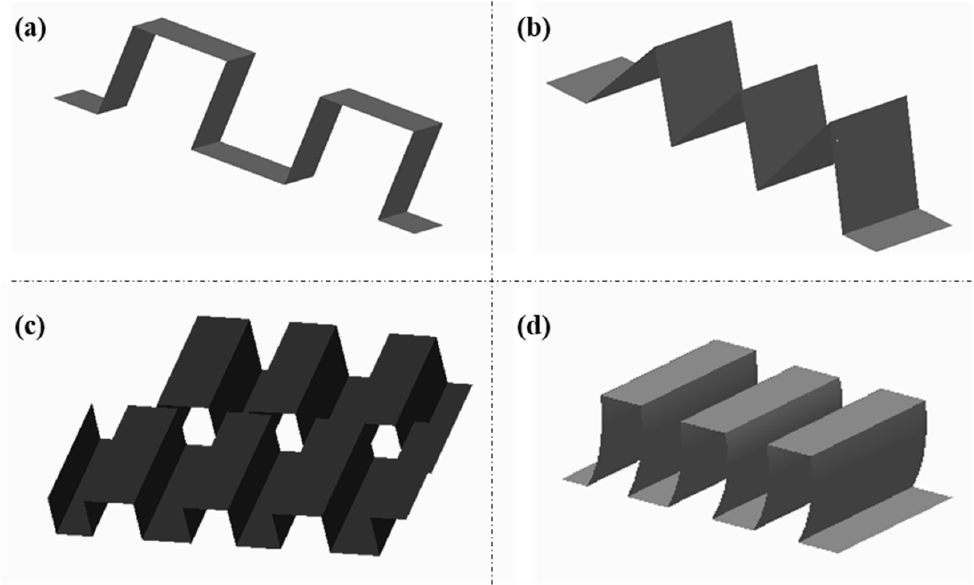
Figure 1. Types of fins. ( a ) Plain fin, ( b ) louvered fin, ( c ) o ff set fin, ( d ) wavy fin [21].